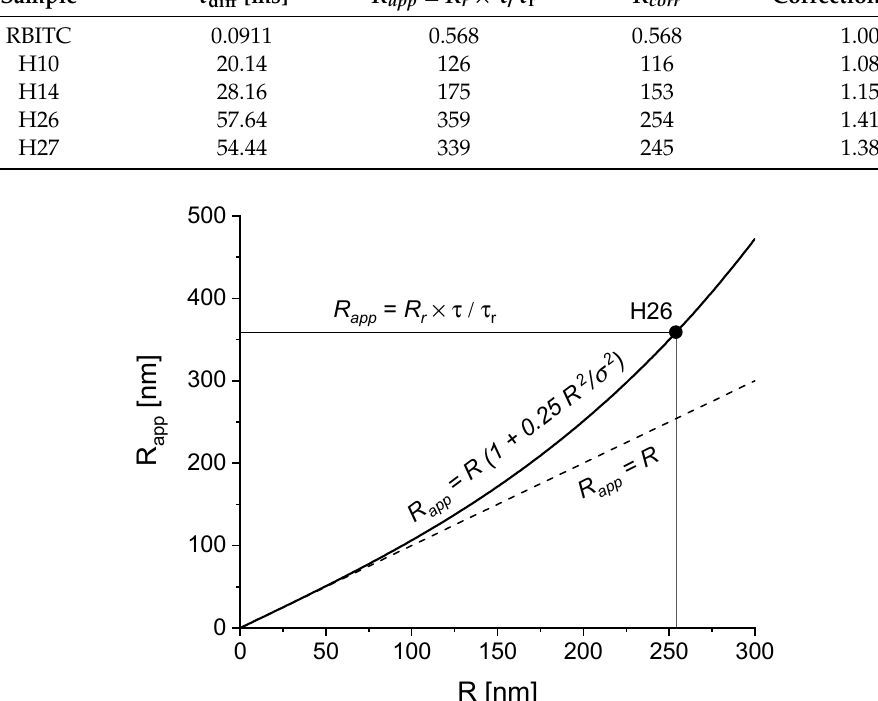
Figure 2. Illustration of the correction procedure of R FCS for the H26 sample.